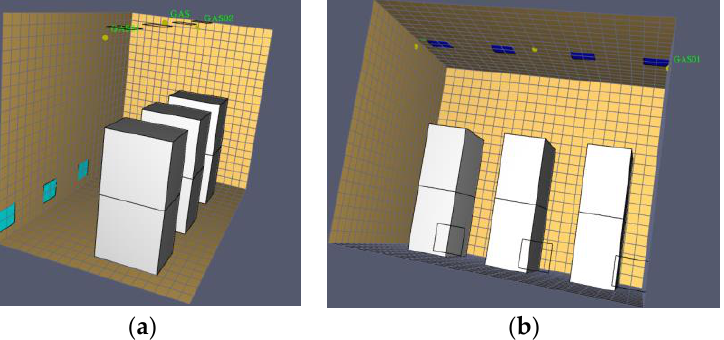
Figure 5. Vent and sensor arrangement in the fuel cell room: ( a ) inlet vents; ( b ) exhaust vents and hydrogen sensors in the ceiling.